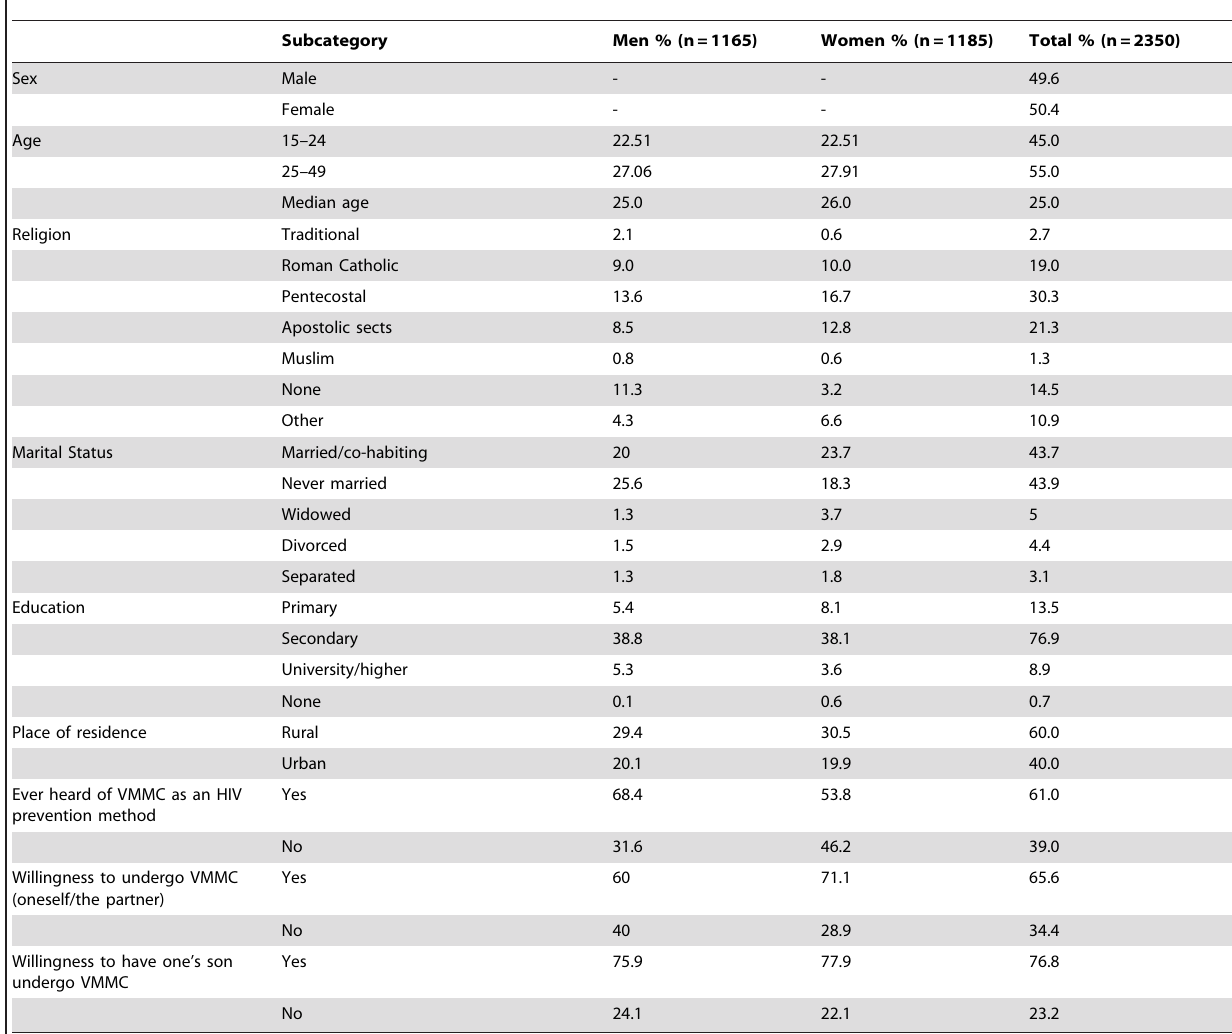
Table 1. Socio-demographic characteristics of survey participants and main outcome variables by